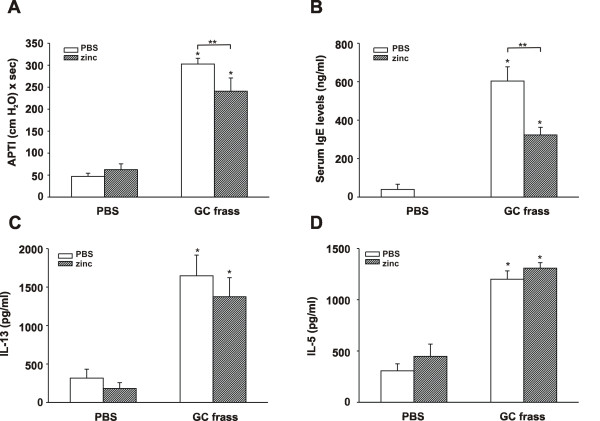
Zinc supplementation decreased experimentally-induced allergic asthma in mice. BALB/c mice were sensitized on days 0, 7, and 14 with an intratracheal inhalation of PBS or GC frass (40 μg/40 μl). On day 14, 15, and 16 selected mice were administered i.p. injections of zinc gluconate (10 mg/kg) or PBS. On day 17, mice were anesthetized and acetylcholine was injected after establishment of a stable airway pressure. Blood was collected and BAL fluid was harvested. Lungs were isolated, and cultured for 3 days in the presence of ConA for cytokine analysis by ELISA. In all cases, means ± SEM (n = 6 mice per group) were reported and statistical significance was determined by one-way ANOVA. A. AHR was measured as airway pressure time index (APTI) in cm-H2O × sec -1 (compared to PBS *p > 0.001; compared to GC frass **p = 0.034). B. Serum IgE levels (compared to PBS *p > 0.001; compared to GC frass **p > 0.001). C. IL-13 levels (compared to PBS; *p > 0.001). D. IL-5 levels (compared to PBS; *p > 0.001).